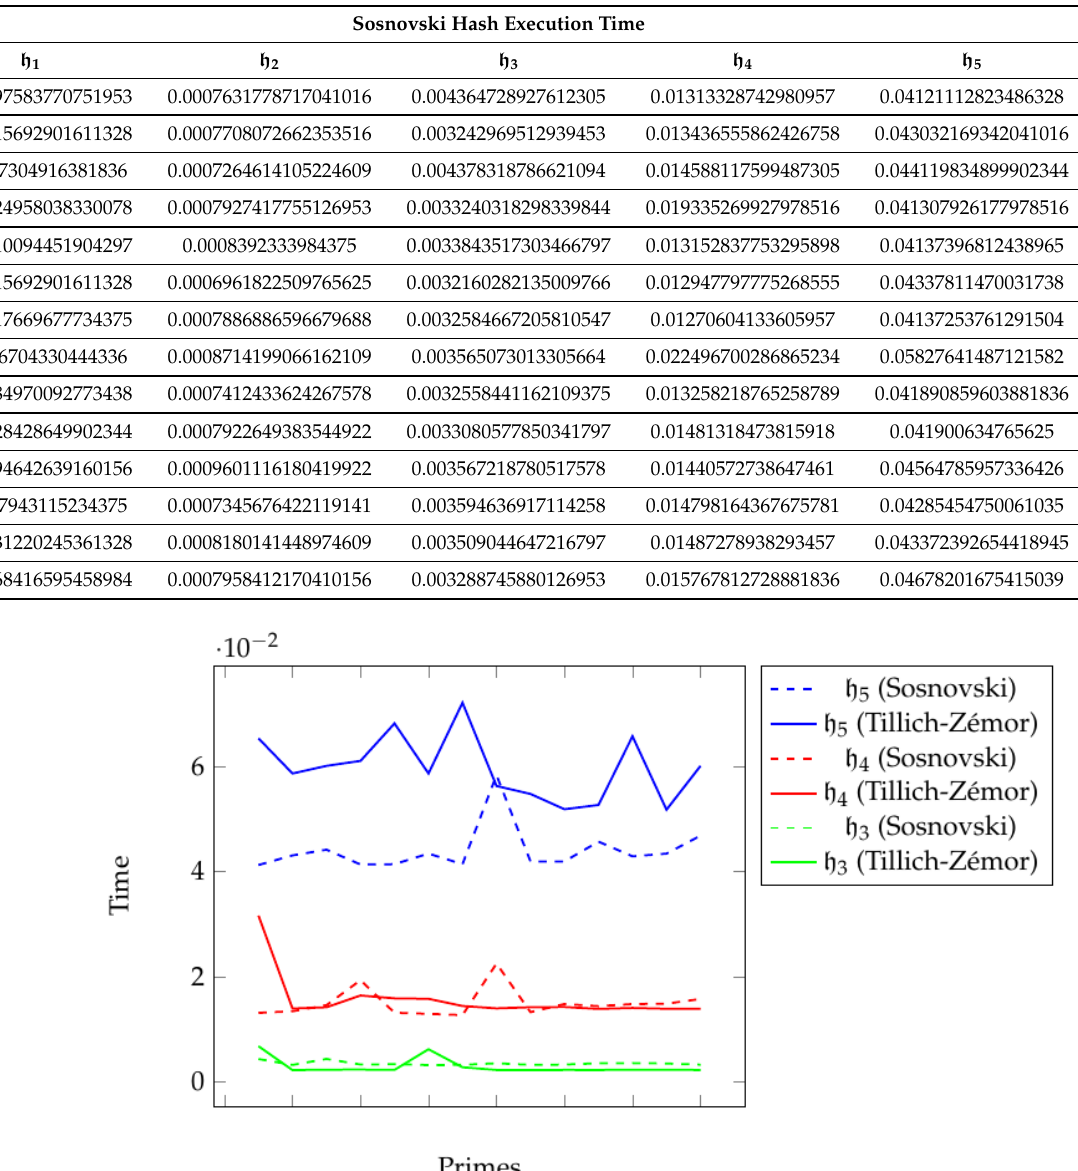
Table 5. Execution time to compute Sosnovski hash values of Brauer messsages.